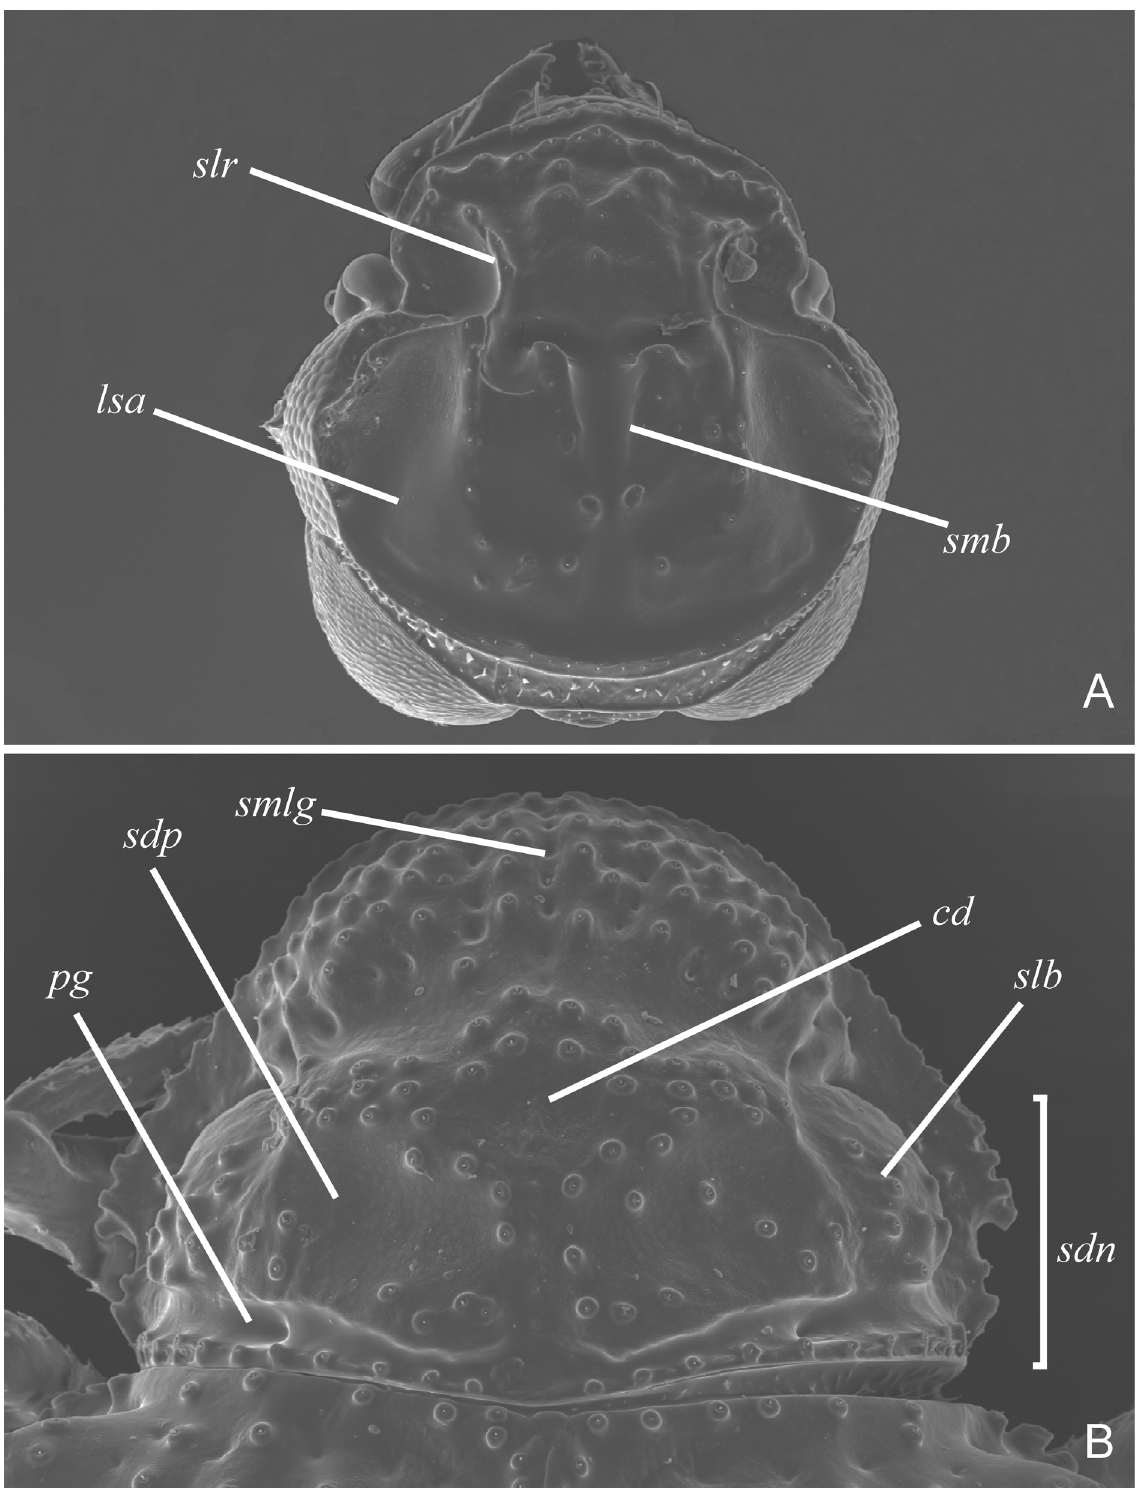
Fig. 1. Georissus (Ne.) kurosawai Nakane, 1963, showing terminology. A . Head. B . Pronotum. Abbreviations: cd = central depression; lsa = lateral smooth area; pg = posterior grooves; sdn = subbasal dentation; sdp = subbasal depression; slb = sublateral bulge; slr = sublateral ridge; smb = submedian bulge; smlg = shallow median longitudinal